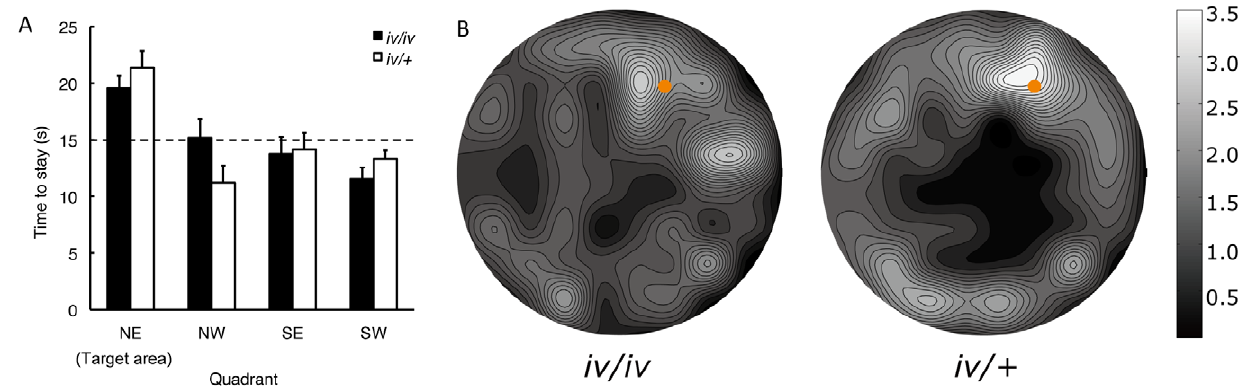
Figure 4. Exploratory behavior during the probe trial of the dry maze. (A) Time spent exploring in quadrants of the open field during the probe trial (NE: north east, NW: north west; SE: south east, SW: south west). NE was the target quadrant, which contained the food-baited hole. A dashed line indicates the prediction from chance. Both groups explored the target quadrant containing the food-baited hole longer than would be expected from chance. (B) The coarse spatial distribution of exploratory behaviors during the probe trial. The open field was fitted into a 10 6 10 square matrix, and the duration spent in each cell was averaged across subjects and then contour plotted using spline interpolation. Orange circles indicate the location of the food-baited hole during training. The exploratory behavior of the iv/ + mice was more focused around the baited hole, whereas it was less focused in iv/iv mice.